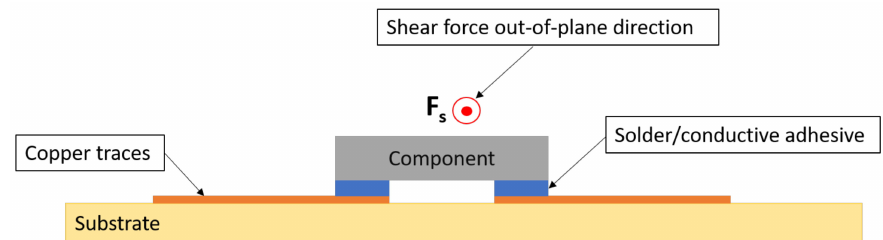
Figure 15. Cross-sectional view for shear off